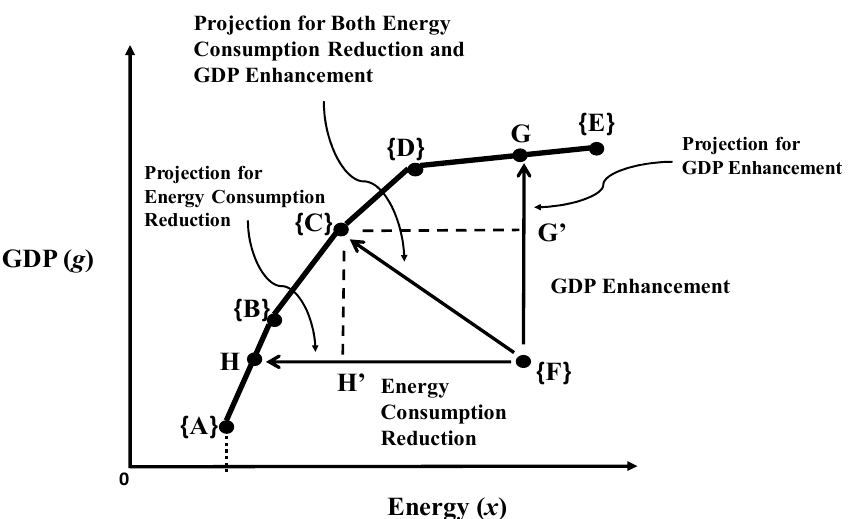
Figure 2. Energy consumption reduction and economic (GDP) enhancement. Note: (a) The authors have prepared the figure for this research. (b) Observed DMUs are listed with { }, while projected observations are not listed without { }. For example, {A} is an observed DMU, and H is a projected performance of {F}. (c) The degree of EI = energy consumption divided by GDP. The output-oriented DEA projects {F} to G. The input-oriented DEA projects {F} to H. The EI reduction needs both the reduction in energy consumption and GDP enhancement. Therefore, we look for the projection from {F} to {C}. In this case, the degree of EI becomes H (cid:48) -{F} divided by G (cid:48) -{F}. (d) The figure indicates the case of a single input and a single output. Meanwhile, we use multiple energy sources as inputs and GDP as an output in this study. In a case containing multiple inputs and outputs, this